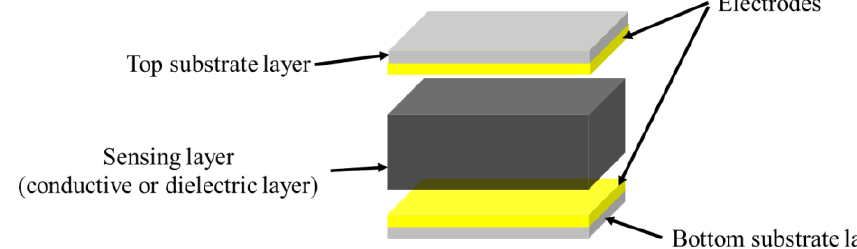
Figure 2. Structural diagram of flexible pressure sensor.